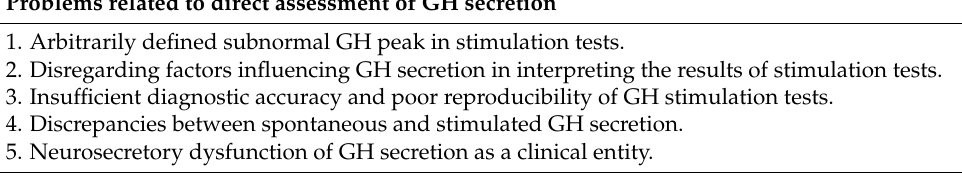
Table 1. Clinical problems related to the diagnosis of isolated GHD and to the optimal duration of rhGH therapy in